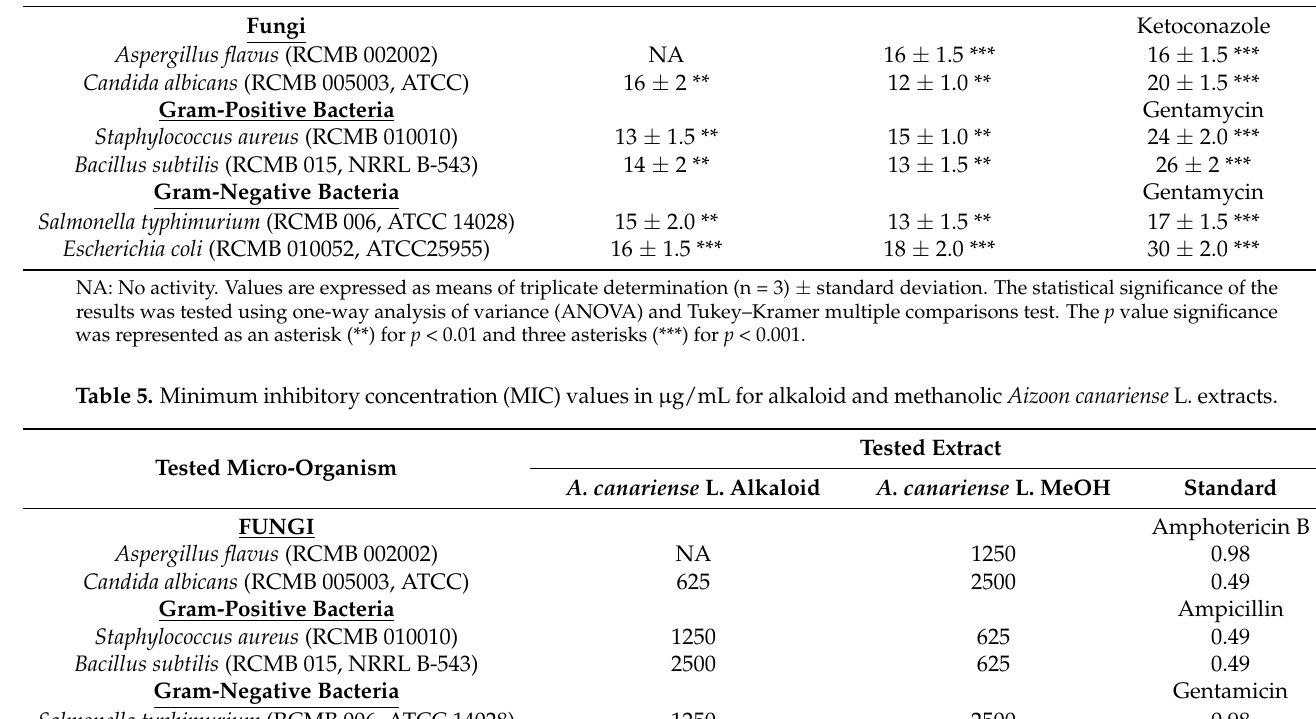
Aizoon canariense L. Alkaloid MeOH